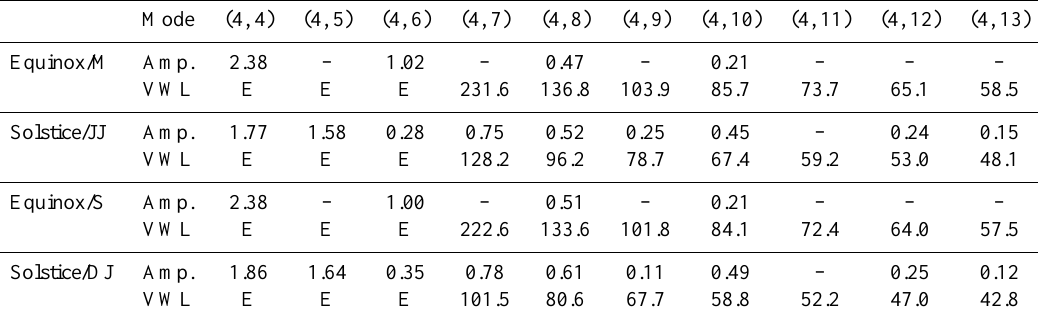
Table 1d. The amplitudes (Amp.) (Kday − 1 ) and the global averaged vertical wavelength (VWL) (km) of the 6-h heating Hough modes near the peak ( ∼ 50km) at 4